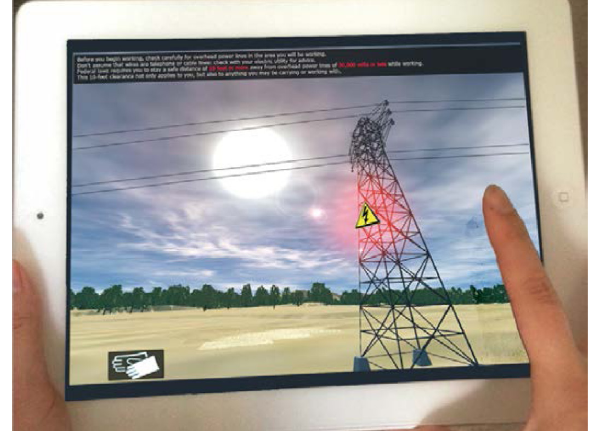
Fig. 5. Prototype interface on iPad